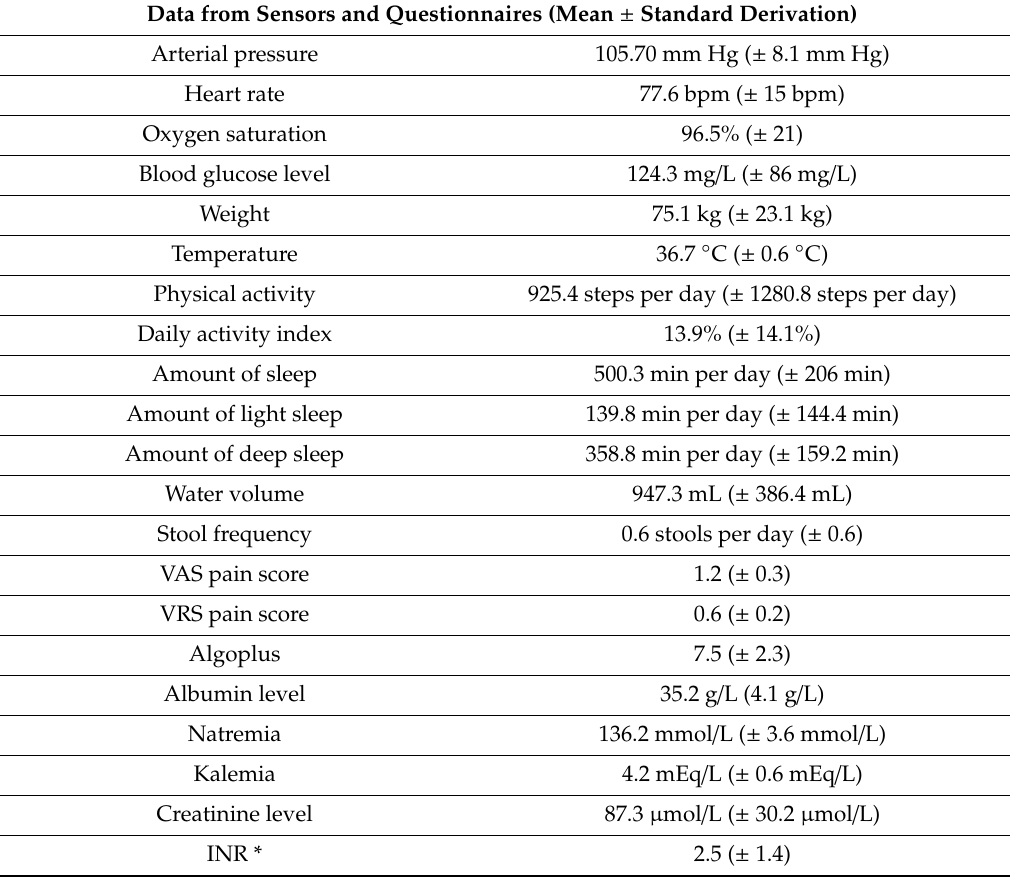
Table 6. Collected data from sensors and questionnaires ( n = 36 patients). Data from Sensors and Questionnaires (Mean ± Standard